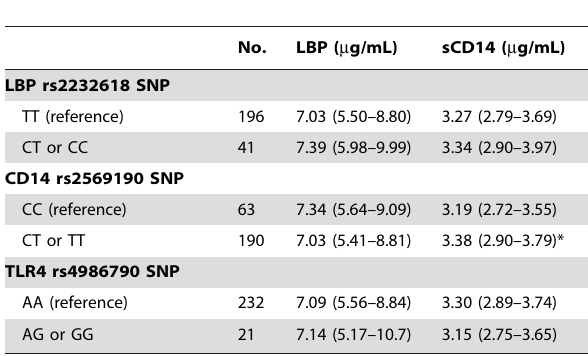
Table 4. Serum concentrations of lipopolysaccharide-binding protein (LBP) and soluble CD14 (sCD14) in relation to common single nucleotide polymorphisms (SNPs) in the LBP, CD14, and TLR4